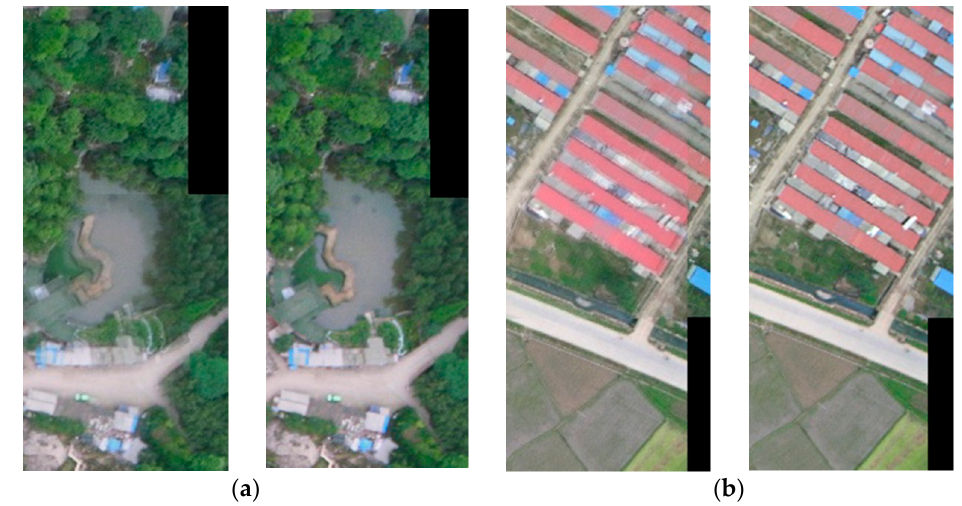
Figure 5. Both ( a ) and ( b ) are the results at the border of the fusion images, in which the left one in ( a ) or ( b ) is with the BTSE method and the right one used the WD-GDWE method.